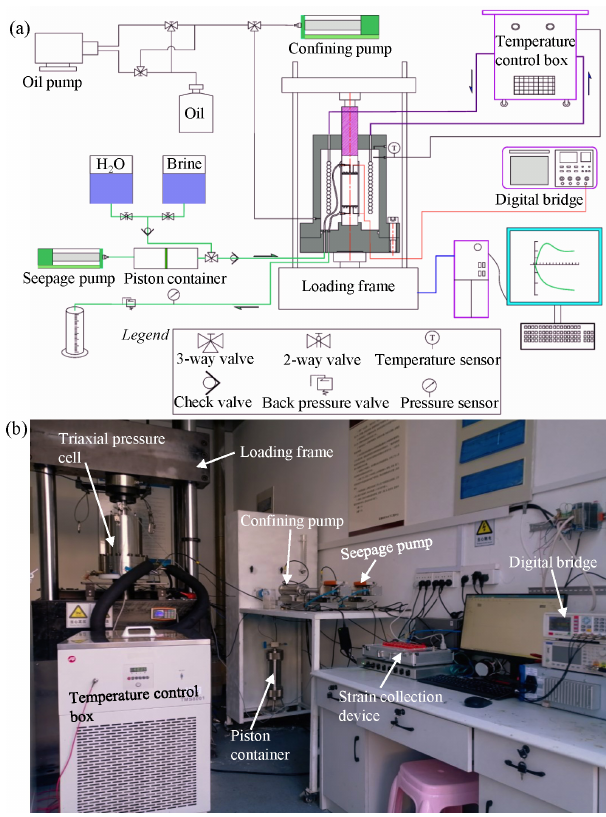
Figure 1. THMC multi-field rock resistivity test system. (a) Schematic diagram. (b) Photo of the